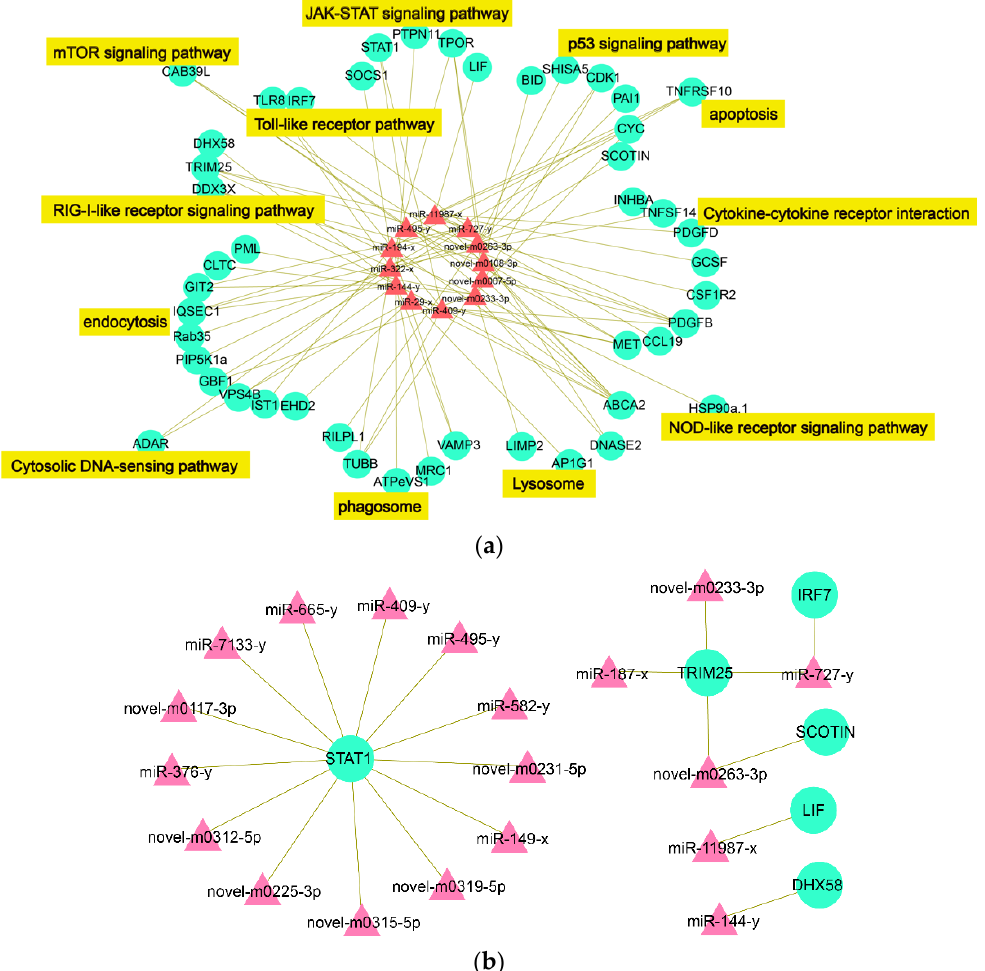
Figure 5. Immune-related miRNA-mRNA interaction networks. ( a ) The immune-related miRNA-mRNA network formed by interactive DEmiRs and DETmRs. The red triangle nodes indicate DEmiRs and the green round nodes indicate DETmRs. The pathways to which the DETmRs belong are highlighted in yellow; ( b ) The mRNA-miRNA networks formed by the key immune-related differential expressed genes (DEGs), identified in a previous mRNA transcriptome study, and their paired DEmiRs. The green round nodes indicate the key immune DEGs and the pink triangle nodes indicate the DEmiRs that target the hub genes of (a).